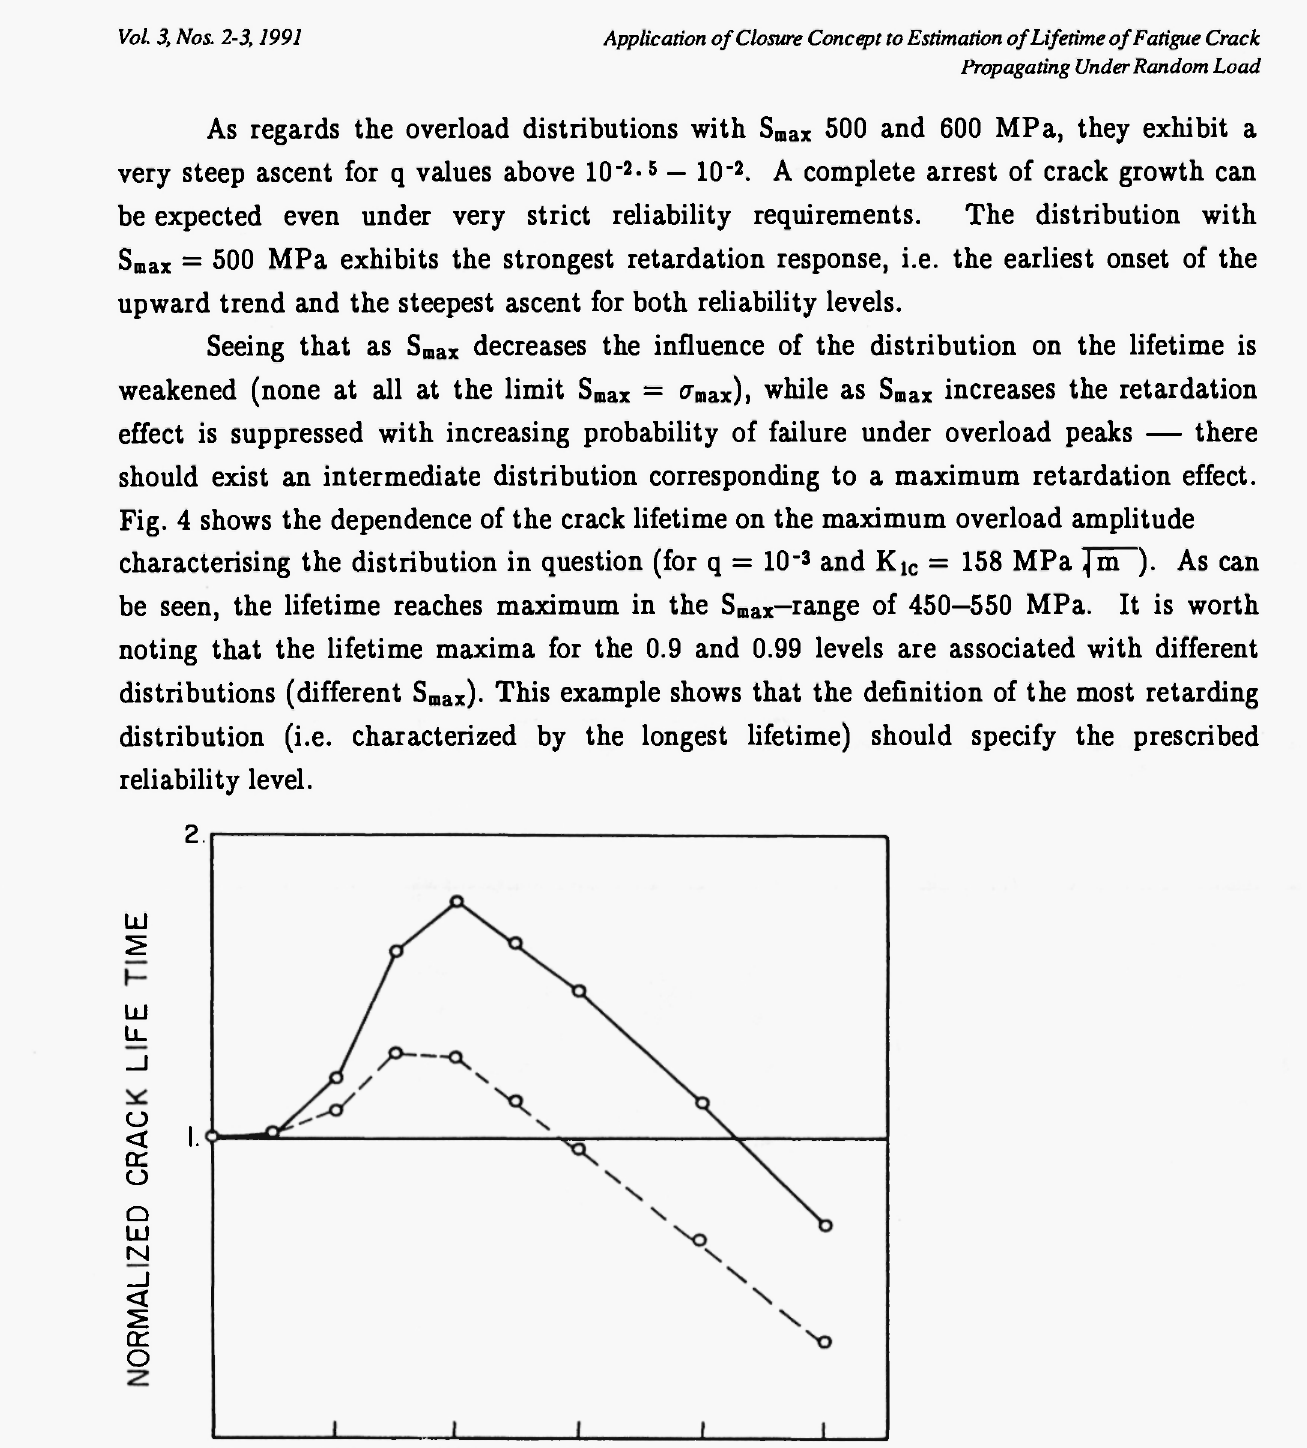
Fig. 4 Dependence of lifetime on maximum overload stresses representing different distributions (minimum overload stress in all distributions 300 MPa). Overload intensity q = 10" 3 , fracture toughness 158